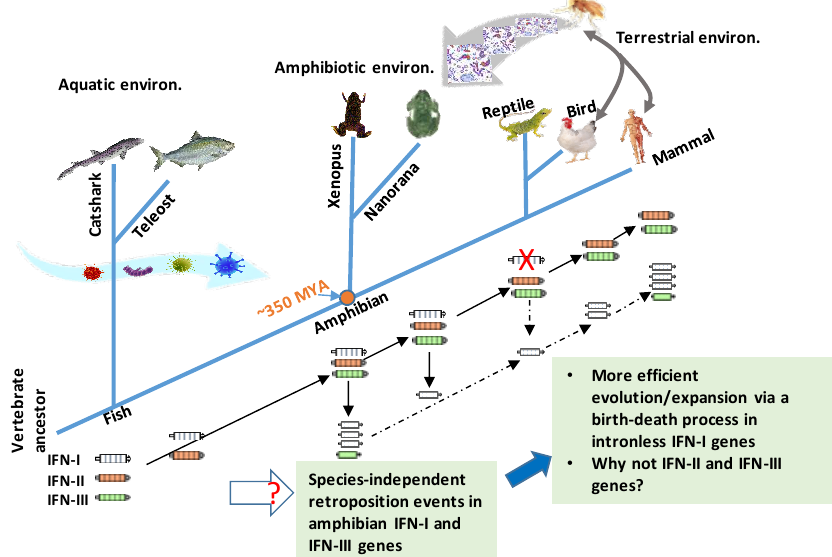
Figure 2. An updated model for antiviral IFN (IFN-I and IFN-III) gene evolution in vertebrates. The ancestral genes of three type of IFNs (IFN-I, -II, and -III) have been identified in cartilaginous fish. All fish IFN genes are intron-containing ones generally with four introns (or five exons) [12]. In contrast, amniotic IFN-I genes are generally intronless. Co-existence of multiple intronless and intron-containing IFN genes were only detected independently in di ff erent species of amphibians [12–16,50,51]. The current evidences support that at least two retroposition events might have happened in amphibians, at about 180.70 MYA (million years ago) in Xenopus and 87.57 MYA in N. parkeri , for example [12–16,50,51]. These two independent retroposition events might have occurred much later than the divergence between amphibians and amniotes (i.e., ~350 MYA, orange dot). Another retroposition event leading to intronless IFN orthologs in amniotes could also happen in accompaniment to loss of intron-containing IFN genes in reptiles; however, it could be unlikely if an orthologous relationship exists between di ff erent intronless amphibian IFNs with amniotic ones [12]. The emergence and expansion of intronless amphibian IFNs likely reflect the increasing evolution pressure (especially the air-borne pathogens and physiological requirement for terrestrial adaptation, shown with broad curve arrows) during the transition period, when vertebrates migrated from aquatic to terrestrial environments. Retroposition defines a reverse-transcription process of cellular mRNA and reintegration into the genome to enhance gene copying and evolution in molecular evolution. Compared to intronless IFN-I genes, one paradox in IFN evolution is why IFN-II and –III genes conserve the ancestral gene structures, and do not show gene expansion even after few intronless IFN-III genes originated in amphibians and other amniotes. Solid or dashed black arrows: Indicating certain or uncertain orthologous relationships discovered,